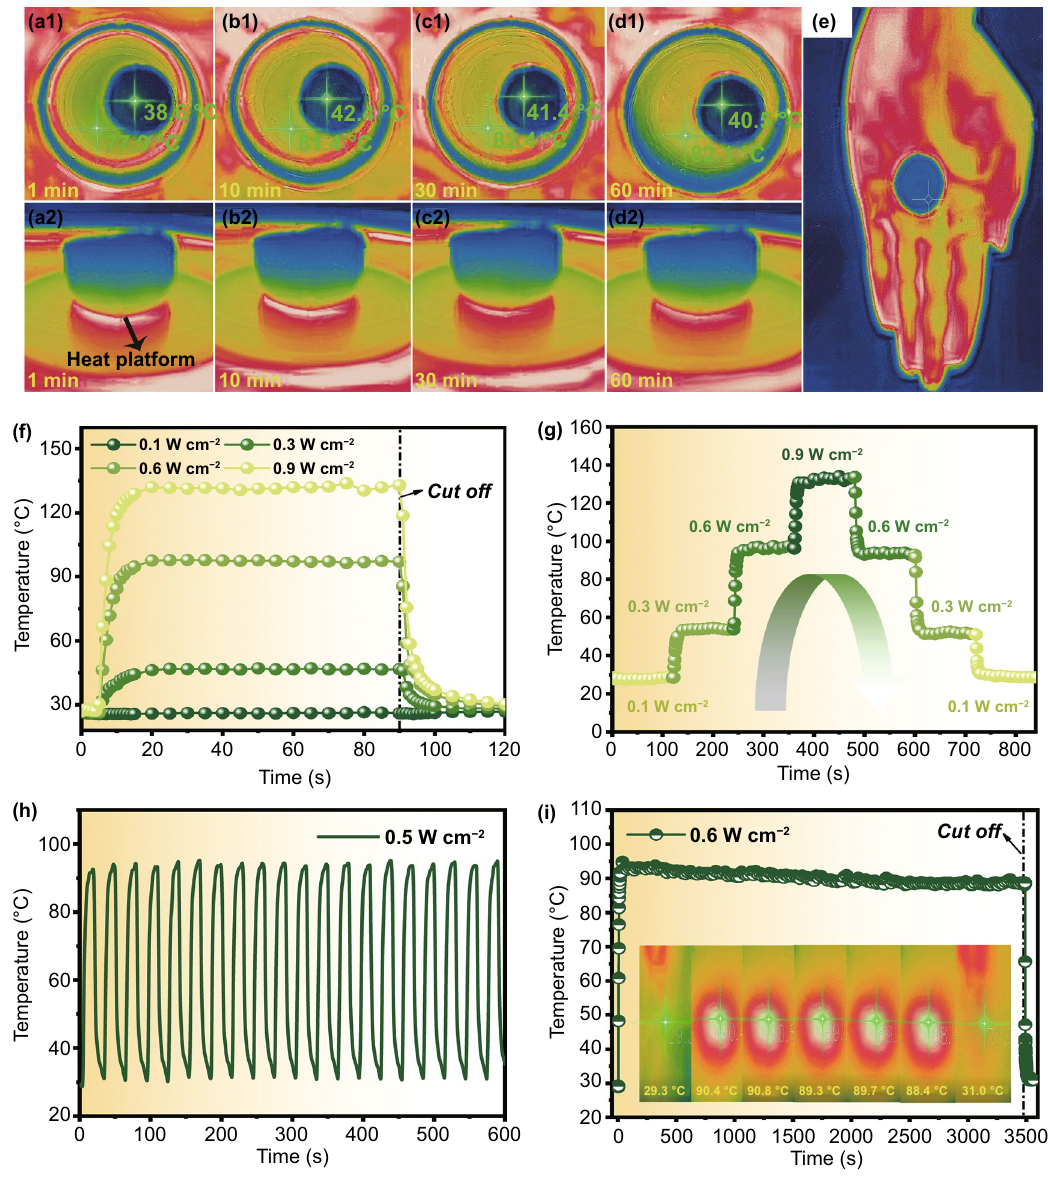
Fig. 9 Top view a1 - d1 and side view a2 - d2 thermal infrared images of CONA-2 on 85 °C platform captured at 1 min/10 min/30 min/60 min, respectively; e thermal infrared images of CONA-2 placed on the hand. Photothermal property of the CONA-2: f photothermal property of the CONF-2 at different power densities; g photothermal property of CONF-2 under gradually changing power density; h photothermal stability of the CONF-2 in 20 light/unlight cycles; i long-term photothermal stability of the CONF-2 within 3600